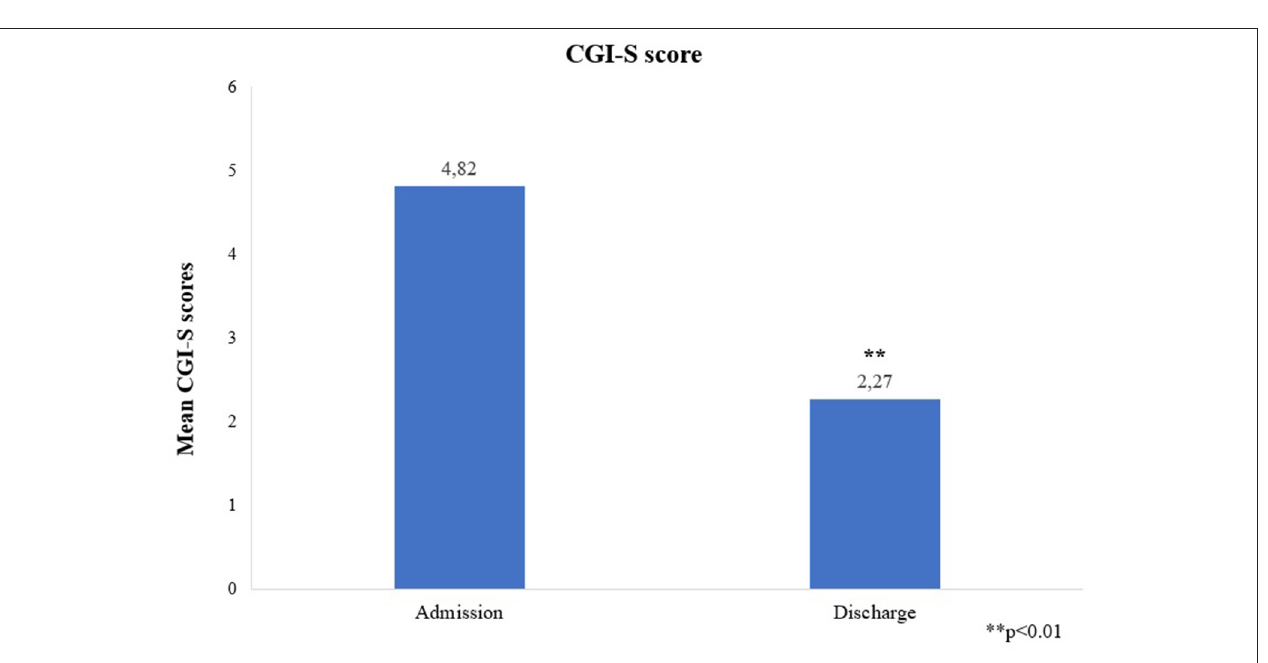
FIGURE 2 | Mean CGI-S scores at admission and discharge. CGI-S, Clinical Global Impression – Severity Scale. **p <